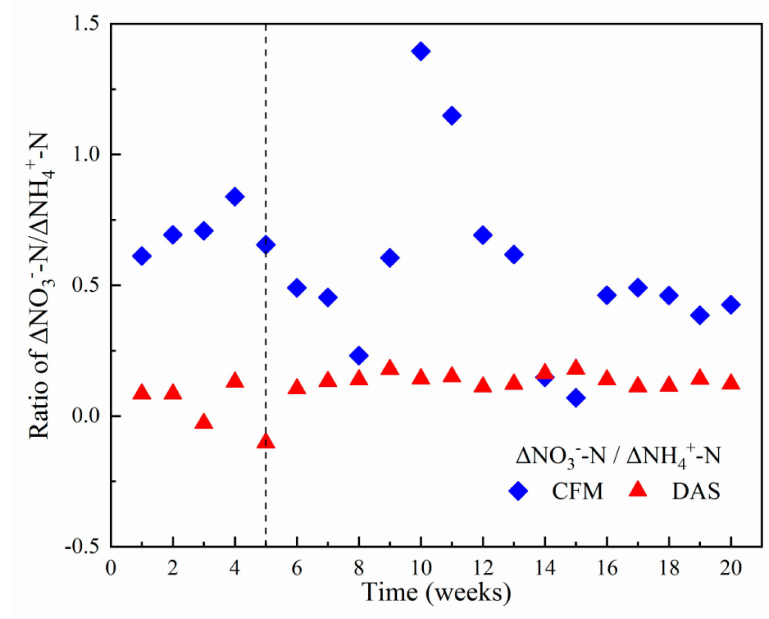
Figure 3. Ratio of ∆ NO 3 − -N / ∆ NH 4 + -N in CFM and DAS